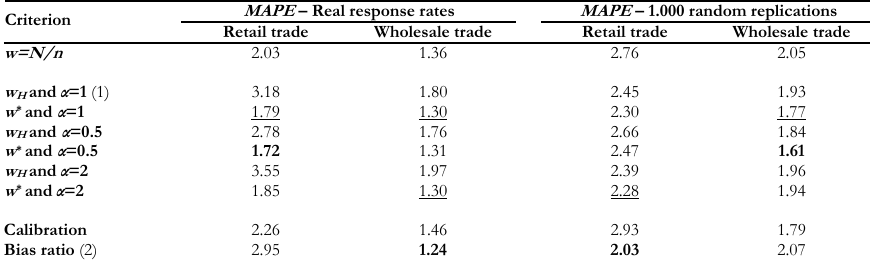
Final comparison among criteria based on the average MAPE in 4 domains: D1, D2, D3, D4 (real response rates and simulated 50% response rates for retail trade and wholesale trade: average of 2007 estimates) MAPE – Real response rates MAPE – 1.000 random replications Criterion Retail trade Wholesale trade Retail trade Wholesale trade